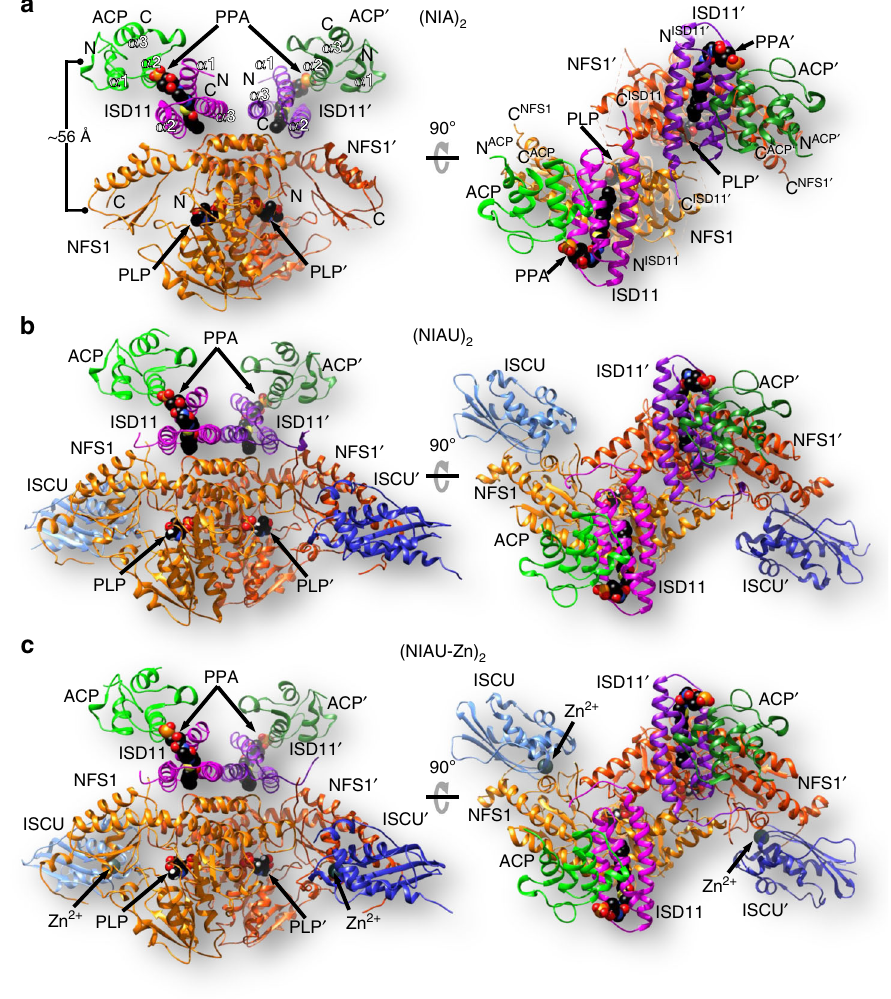
Fig. 1 Crystal structures of (NFS1-ISD11-ACP) 2 and (NFS1-ISD11-ACP-ISCU) 2 complexes. Overview of the 3D structures of the a (NIA) 2 , b (NIAU) 2 , and c (NIAU-Zn) 2 complexes. NFS1 is depicted in orange, ISD11 in magenta or purple, ACP in green, and ISCU in blue. Pyridoxal phosphate (PLP) and the phosphopantetheine with its fatty acyl chain (PPA) are depicted in black as spheres. In part a the ~56 Å distance between the centers of NFS1 and ACP as well as the N and C termini are indicated NATURE COMMUNICATIONS | 8: 1287 | DOI: 10.1038/s41467-017-01497-1 |